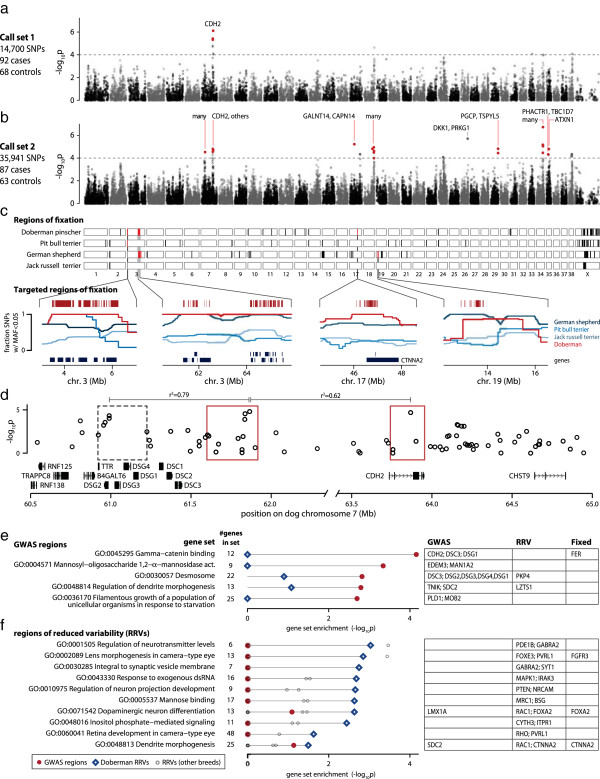
Associated and fixed regions in Doberman Pinschers are enriched for brain-related pathways. (a) The original GWAS dataset showed a single peak of association at CDH2[14]. (b) Recalling with MAGIC yielded a 2.4-fold denser SNP dataset and allowed us to define 17 distinct regions of association with P < 0.0001 using linkage disequilibrium (LD) clumping (Figure S1 in Additional file 1), a subset of which were targeted for sequencing (red dots, genes labeled above peak). (c) In four breeds with high rates of OCD, we identified regions of fixation (black boxes), a subset of which we targeted for sequencing (red boxes). Sequenced regions were selected because they were large and overlapping between breeds (Table S1 in Additional file 1). (d) LD clumping identified three distinct regions of association on chromosome 7 (boxes, with targeted regions in red). (e) The top Gene Ontology gene sets enriched in the GWAS regions. (f) GO gene sets enriched in Doberman Pinscher regions of reduced variability (RRVs) but not in 24 other breeds (grey circles, most at 0).